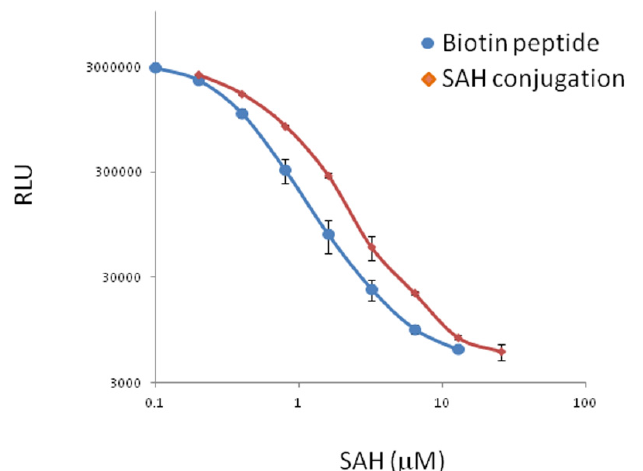
Figure 2. SAH calibration curves in competitive immunoassay using the biotin-mimotope peptide or SAH conjugated to the assay plate. Chemiluminescent detection was achieved with an HRP-conjugated secondary antibody (n =